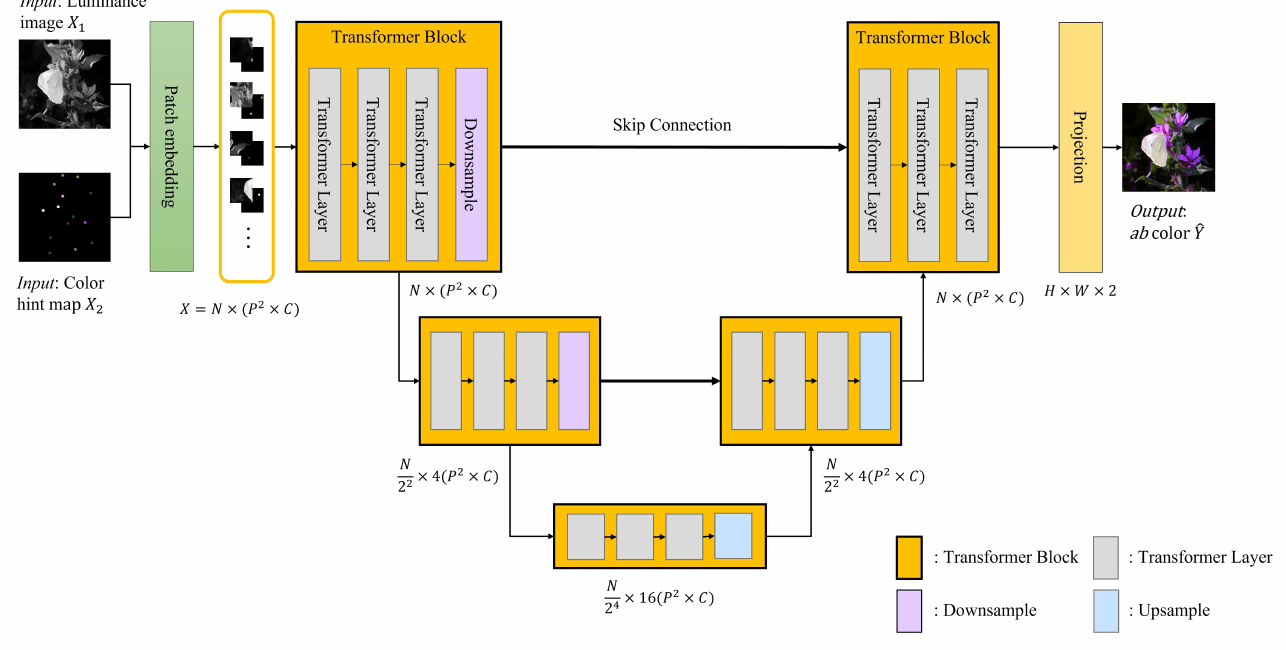
Figure 1. Overall architecture of the proposed hint-based colorization transformer network